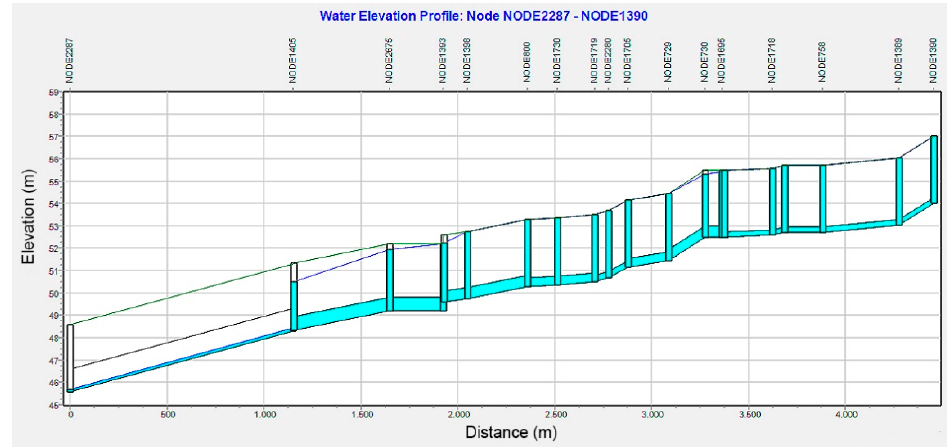
Figure 7. Water elevation profile at the peak moment, TR = 25 years, Via XXIV Maggio.